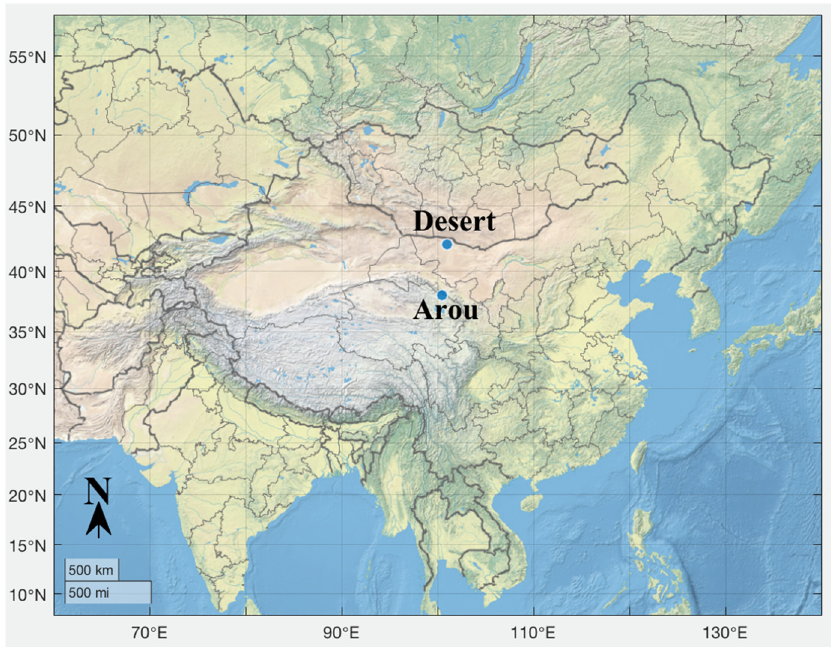
Figure 3. Location of the two study sites (i.e., Arou and Desert) in the Gobi Desert in China.